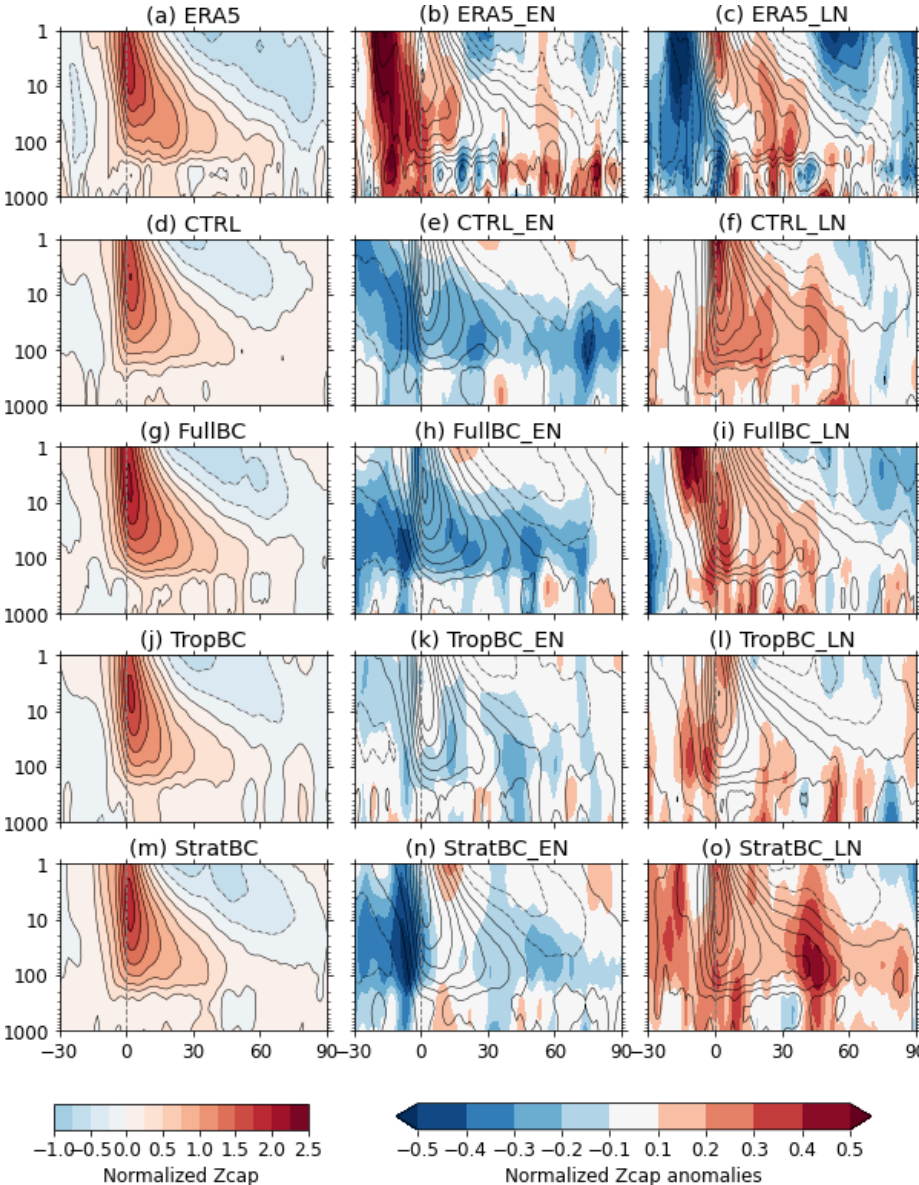
Figure 6. SSW response of normalized polar cap (60–90 ◦ N) geopotential height, composited around SSW day zero (shown as a dashed vertical grey line). The left column shows neutral years for the experiments and all years for ERA5. The middle column shows the SSW response in El Niño years with contours (negative values dashed) and the El Niño anomalous SSW response in colours (normalized polar cap geopotential height in El Niño years minus neutral years). The right column is the same for La Niña. ERA5 data from 1979–2019, 100 years for each model run (neutral, El Niño, and La